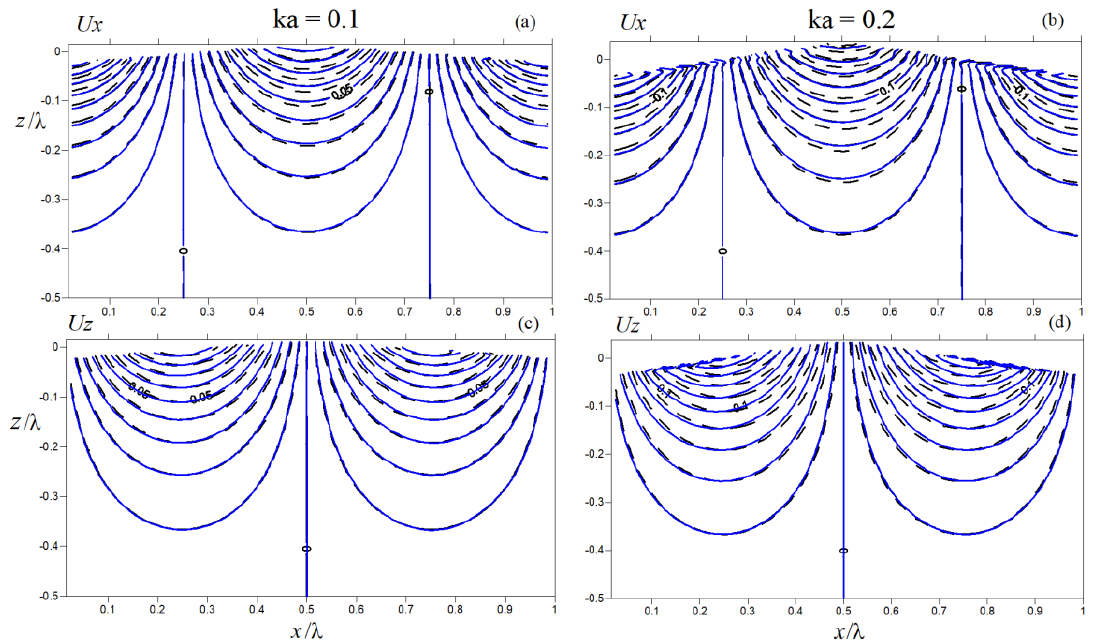
Figure 3. Phase-averaged water velocity components, U x ( a , b ) and U z ( c , d ), obtained using DNS with wave slope ka = 0.1 ( a , c ) and ka = 0.2 ( b , d ) with and without bubbles (black and blue lines, respectively). Dashed line shows analytical solution for the deep-water surface wave [1]; U d = 0.